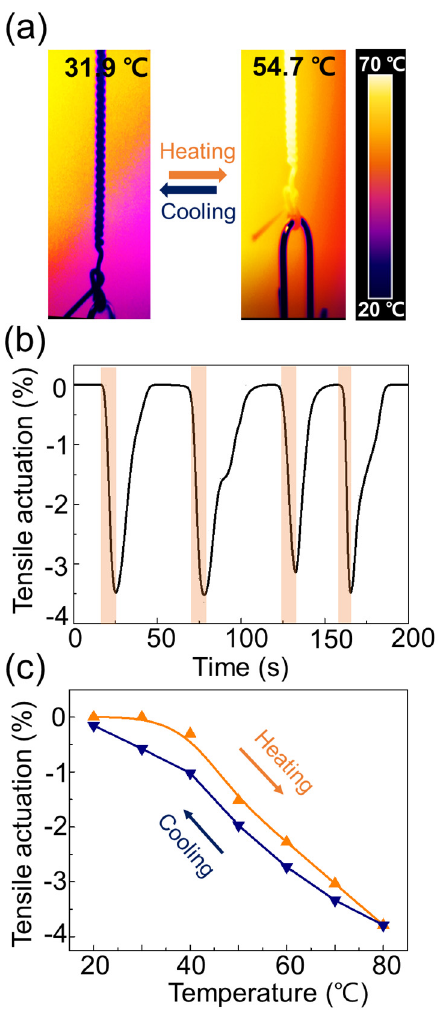
Figure 3. Thermomechanical actuation of coiled artificial muscle: ( a ) infrared thermal images of coiled artificial muscle; ( b ) tensile stroke of coiled nylon when heated by hot air; ( c ) tensile stroke versus temperature of coiled 102 µ m diameter nylon monofilament muscle, under 9.4 MPa static load.